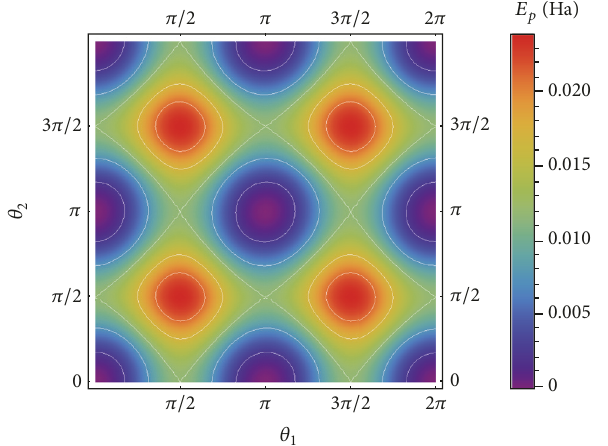
Figure 8: Torsional PES of orthodinitrobenzene. The conforma- tional energies (in Hartree) of the minima are set to zero. The barriersaround ( 𝜋,𝜋 ) are0.1989 Ha, and thebarriersare0.0101Ha at ( 𝜋/2 , 𝜋/2 ). Different from the previous two isomers, the zero energy point is located at ( 𝜋/4 , 5𝜋/16 ) and the symmetric permutations. The Legendre expansion places the minimum at ( 1.107, 1.107 ), which is closest to the point ( 𝜋/4 , 𝜋/4 ).